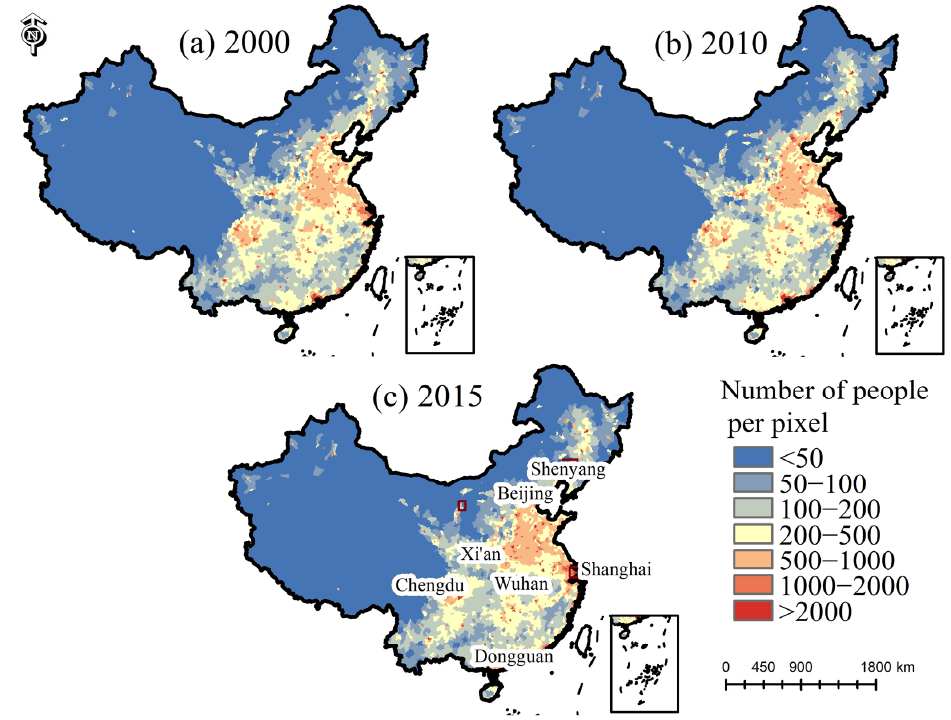
Figure 6. The population density map.